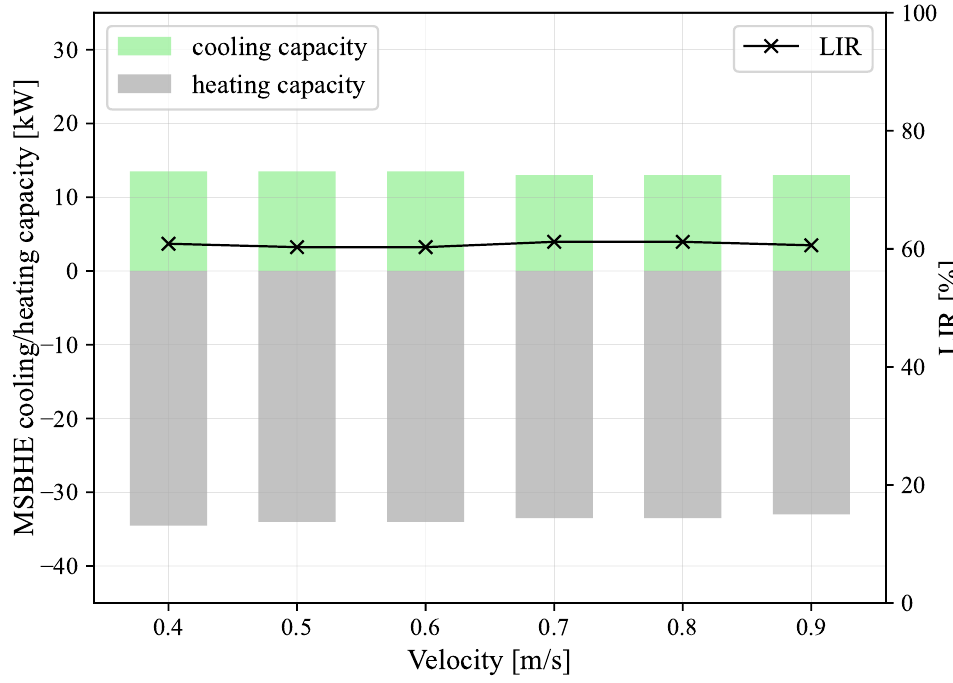
Figure 5. Maximum cooling and heating load of MSBHE and LIR under different flow